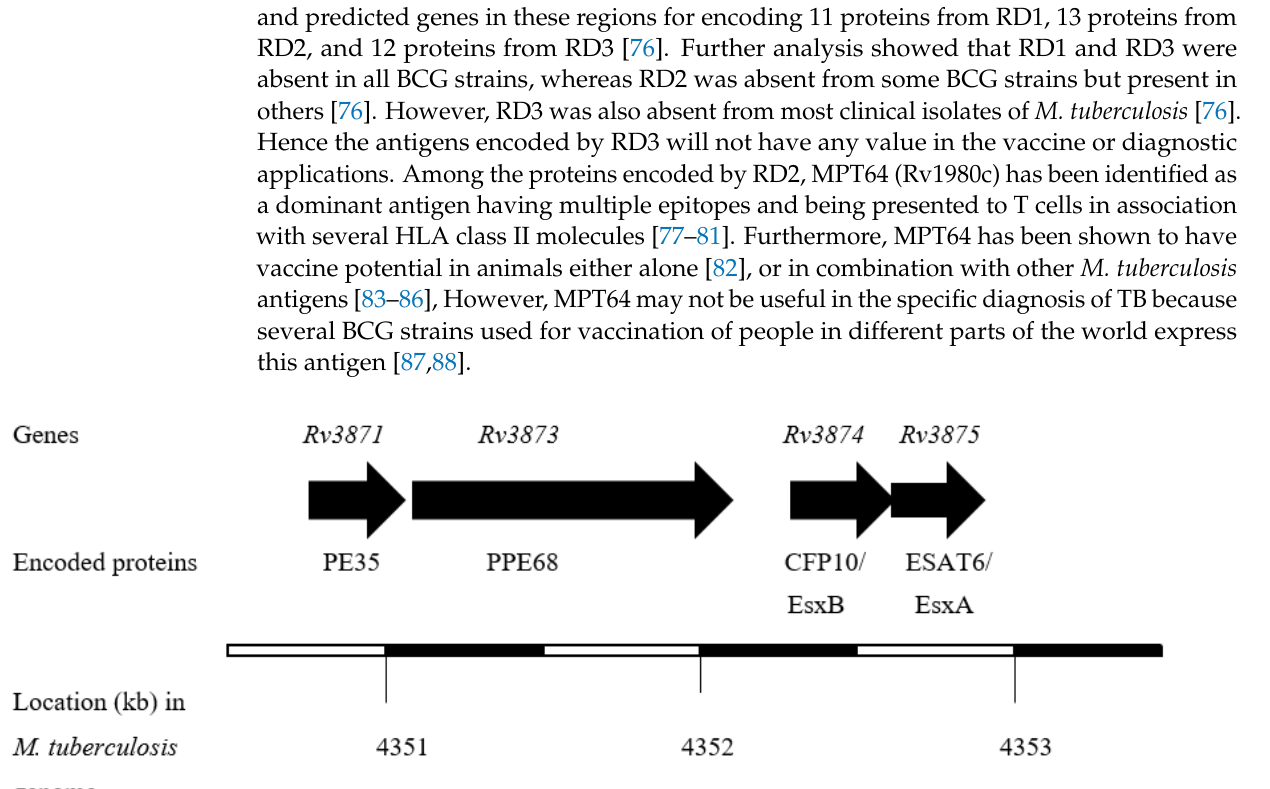
Table 1. M. tuberculosis genomic regions deleted in all strains of Bacillus Calmette Guerin ( BCG) and annotations of deleted genes in the lab-adopted virulent M. tuberculosis strain H37Rv. Region Deleted (RD) a Annotations (Rv nos.) of Deleted Genes b RD1